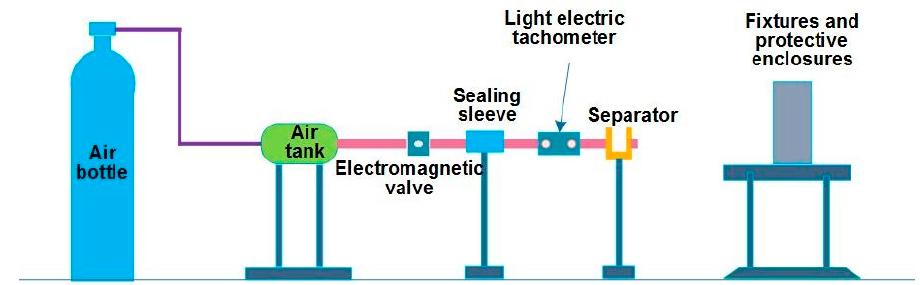
Figure 1. Diagram of the gas gun impact test system.